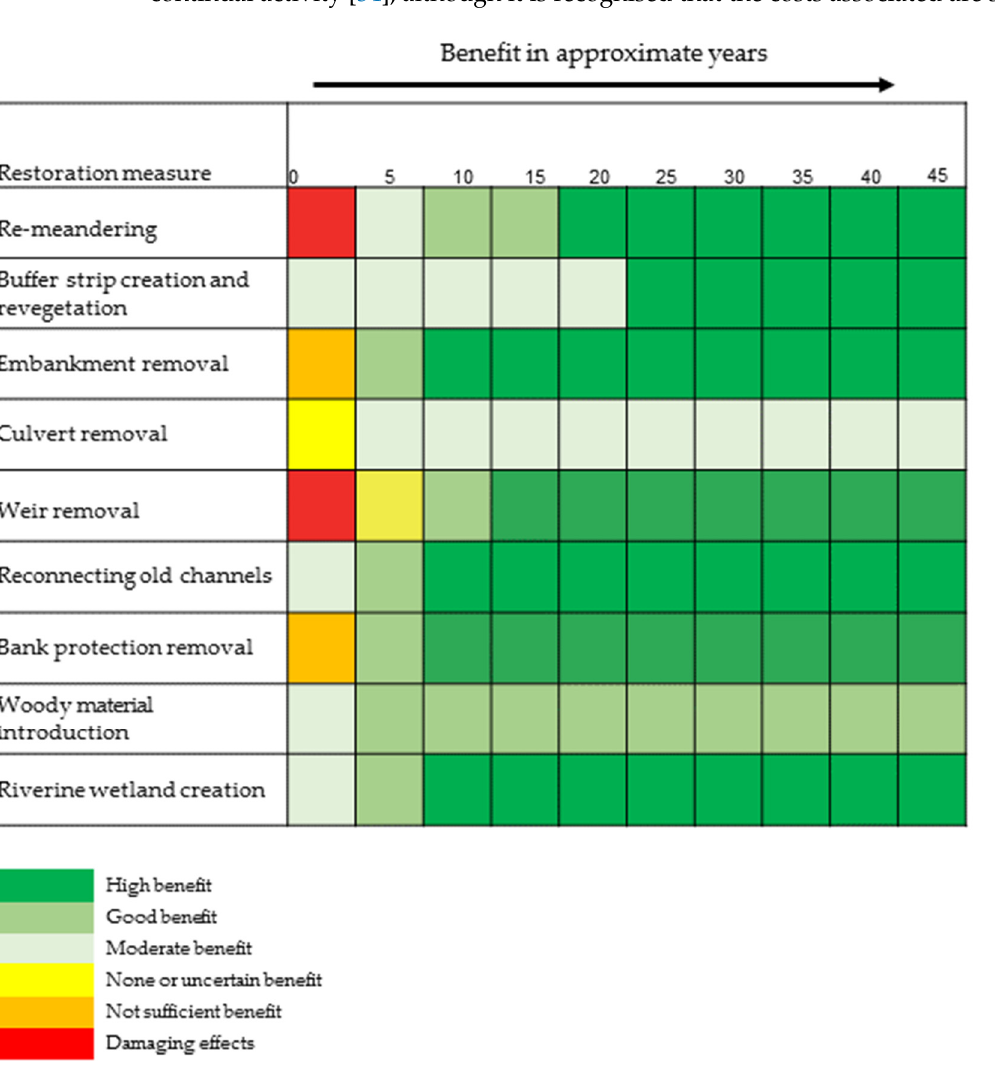
Figure 3. Timescales of biodiversity response, adapted from [112]. * Woody material introduction refers to the one-off addition of large wood to mimic fallen trees or act as flow deflections. The long term uncertainty reflects the decomposition of the wood.